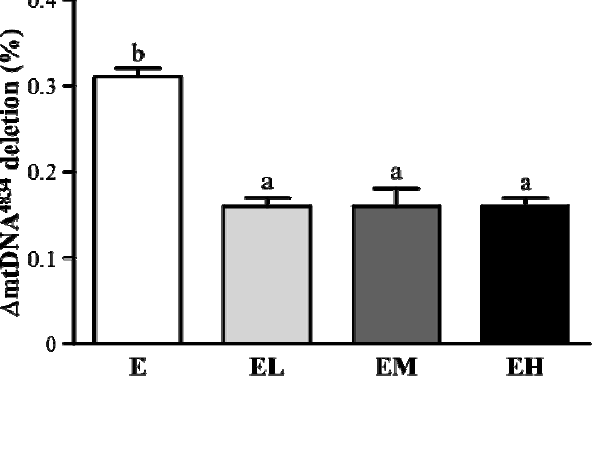
Figure 4. G. tsugae effect supplement on  mtDNA 4834 deletion in liver tissues after exhaustive exercise. Male SD rats were pre-treated with 0, 0.1875, 0.9375, and 1.875 g/kg of G. tsugae (E, EL, EM and EH) for 30 days and subjected to exhaustive treadmill exercise. Data are presented as mean ± SEM of six rats in each group. Columns with different letters (a, b) differ significantly, p < 0.05 using one-way